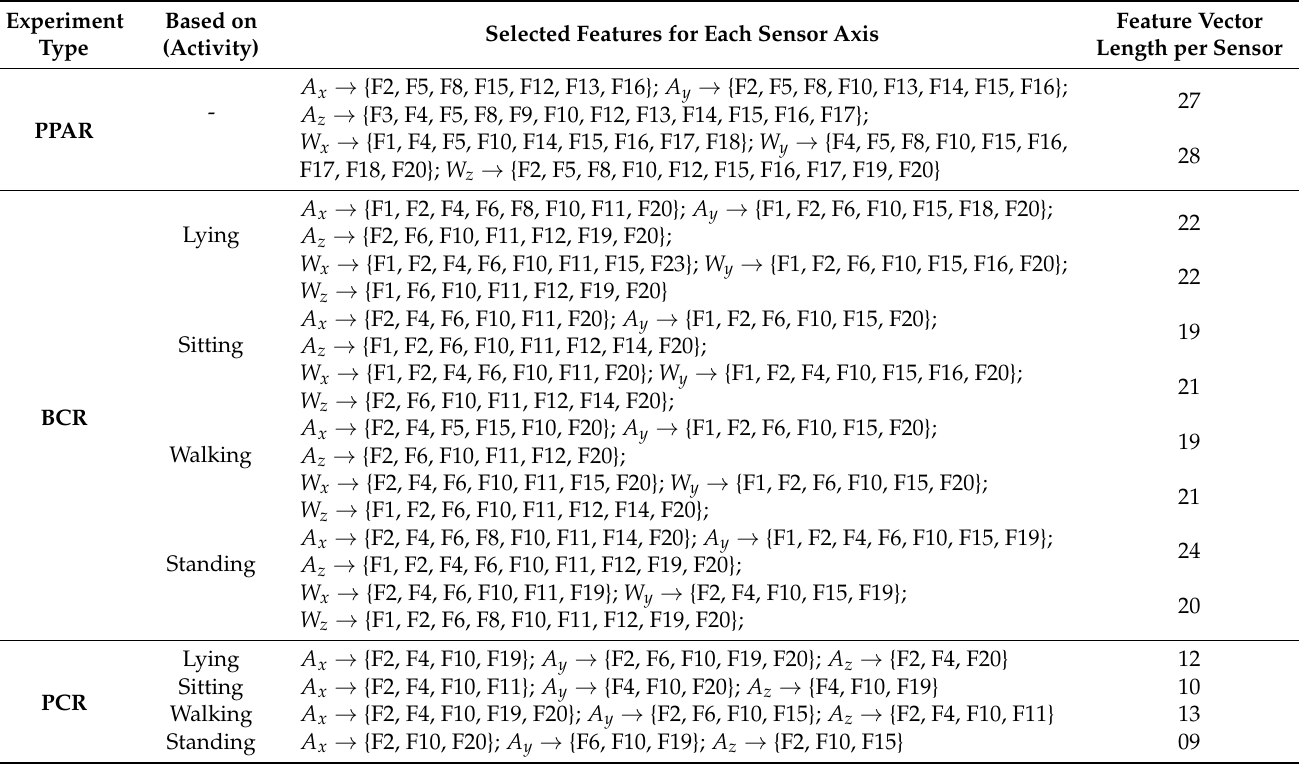
Table 2. List of finally selected features for different recognition experiments in the proposed scheme. Selected Features for Each Sensor Axis